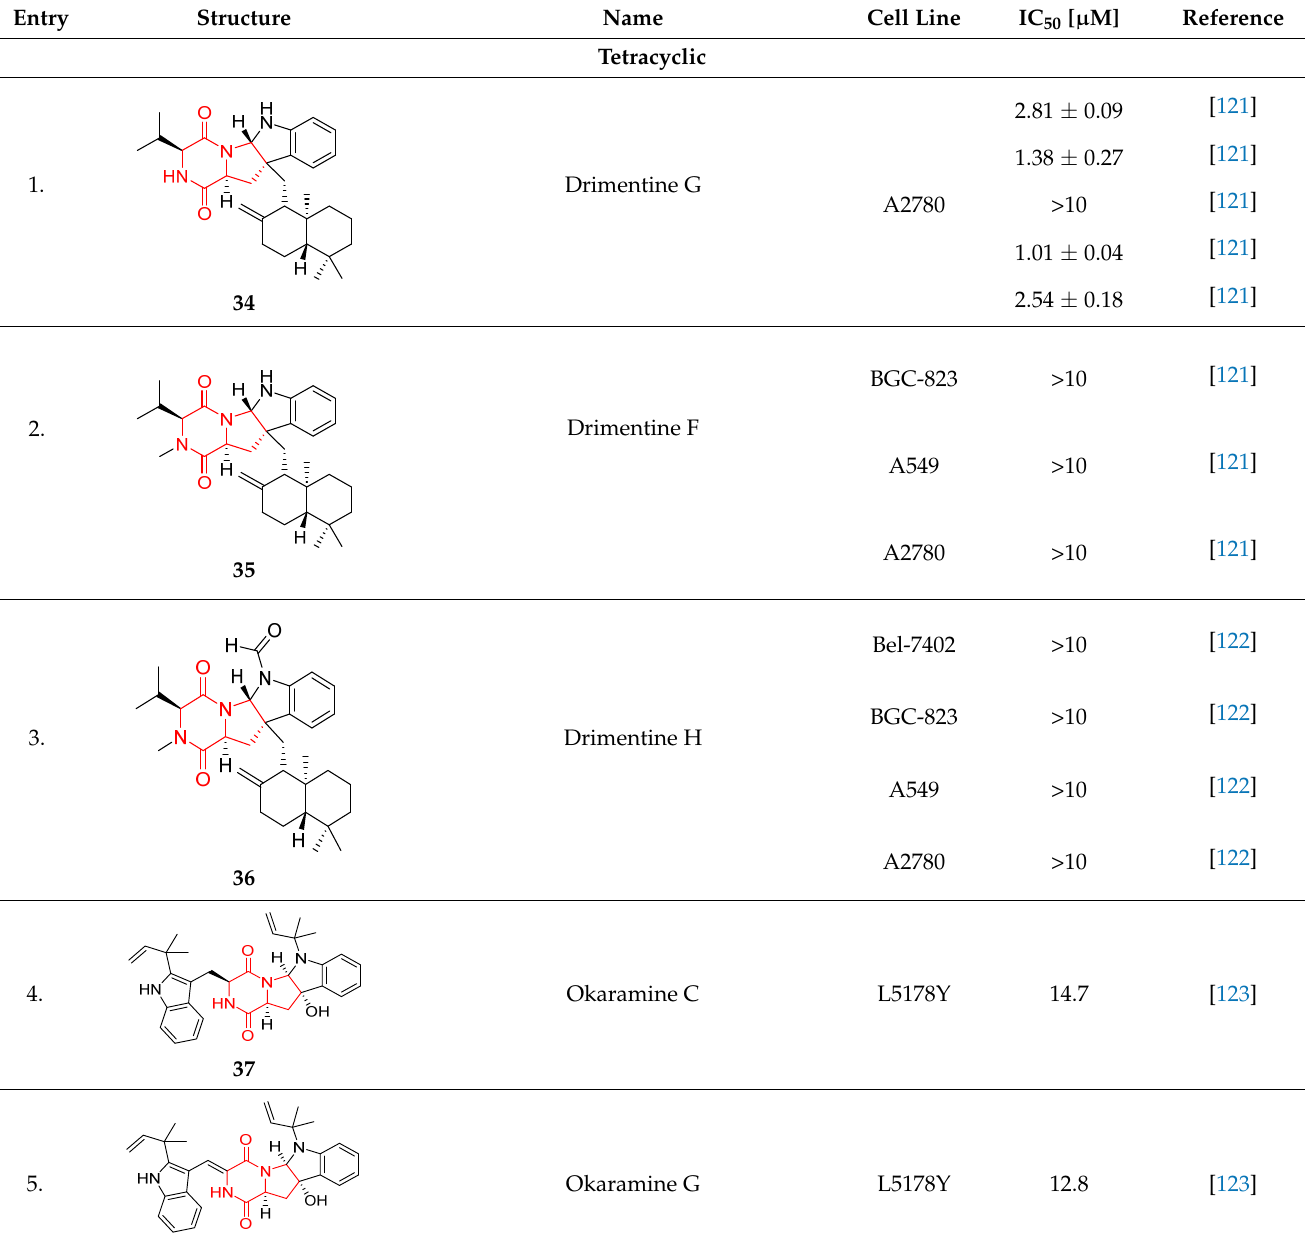
Table 3. Tetracyclic proline ‐ based DKP.